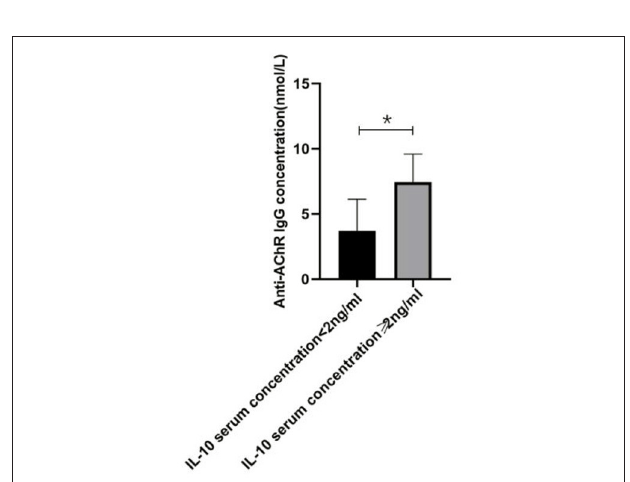
FIGURE 4 | The relationship between IL-10 and anti-AChR Ab concentration. There was a significant difference in the anti-AChR Ab levels between gMG patient groups with low and high IL-10 concentrations. Generalized MG patients with high IL-10 concentration was usually accompanied by a significant increase in anti-AChR Ab levels ( p = 0.034). The data were shown as mean with ± SD of each group, *means p < 0.05, **means p < 0.01. N = 5 for each group within gMG